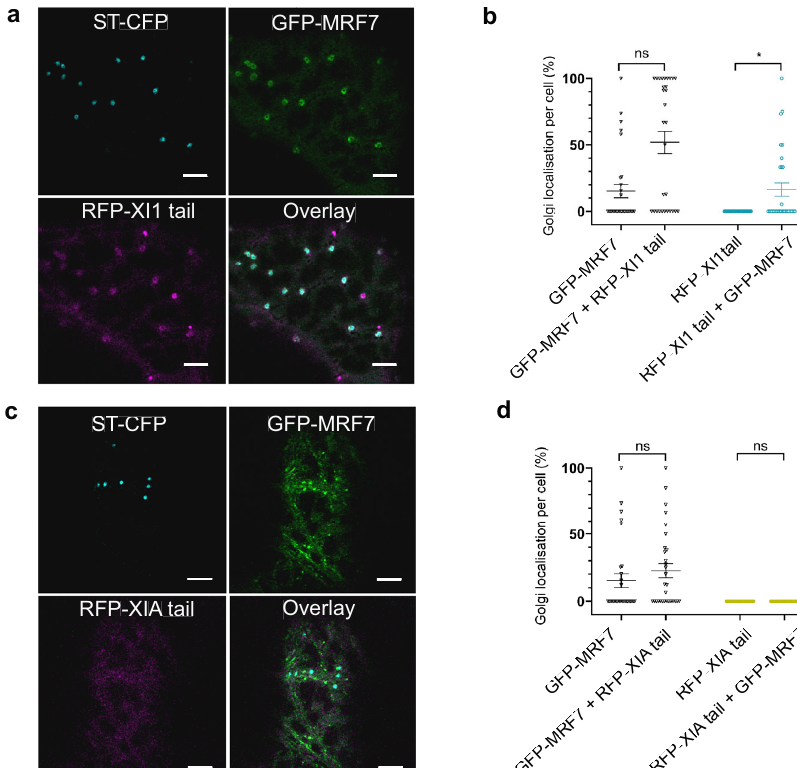
Fig. 7 Effects of GFP-MRF7 expression on myosin XI-1 and XI-A tails localisation. a RFP-XI1 tail (magenta) localises to the Golgi in the presence of GFP- MRF7 (green). ST-CFP (cyan) labels the Golgi stacks. b Quanti fi cation of the Golgi localisation of GFP-MRF7 (black datapoints) and RFP-XI1 tail (cyan datapoints) when expressed with Golgi marker only, or following co-expression with each other and the Golgi marker. RFP-XI-1 tail signi fi cantly increases the Golgi localisation of GFP-MRF7 (black datapoints), similarly, GFP-MRF7 signi fi cantly increases Golgi localisation of RFP-XI-1 tail (cyan datapoints). c RFP-XIA tail (magenta) does not re-localise to the Golgi in the presence of GFP-MRF7 (green). ST-CFP (cyan) labels the Golgi stacks. d Quanti fi cation of the Golgi localisation of GFP-MRF7 (black datapoints) and RFP-XIA tail (yellow datapoints) when expressed with Golgi marker only, or following co- expression with each other and the Golgi marker. RFP-XIA tail does not signi fi cantly increase the Golgi localisation of GFP-MRF7 (black datapoints). GFP- MRF7 does result in RFP-XIA tail (magenta datapoints) localisation to the Golgi. b , d Each datapoint representing one cell (mean± SEM), n = 30,